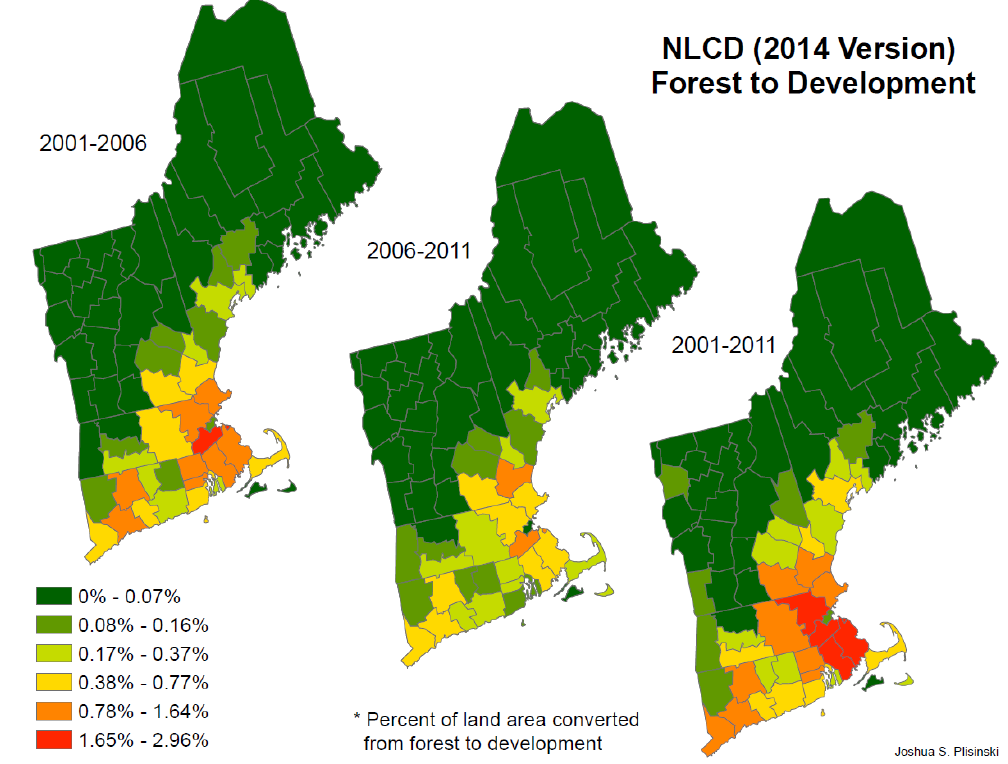
Figure 1. Intensity of forest conversion to developed land in New England by county.